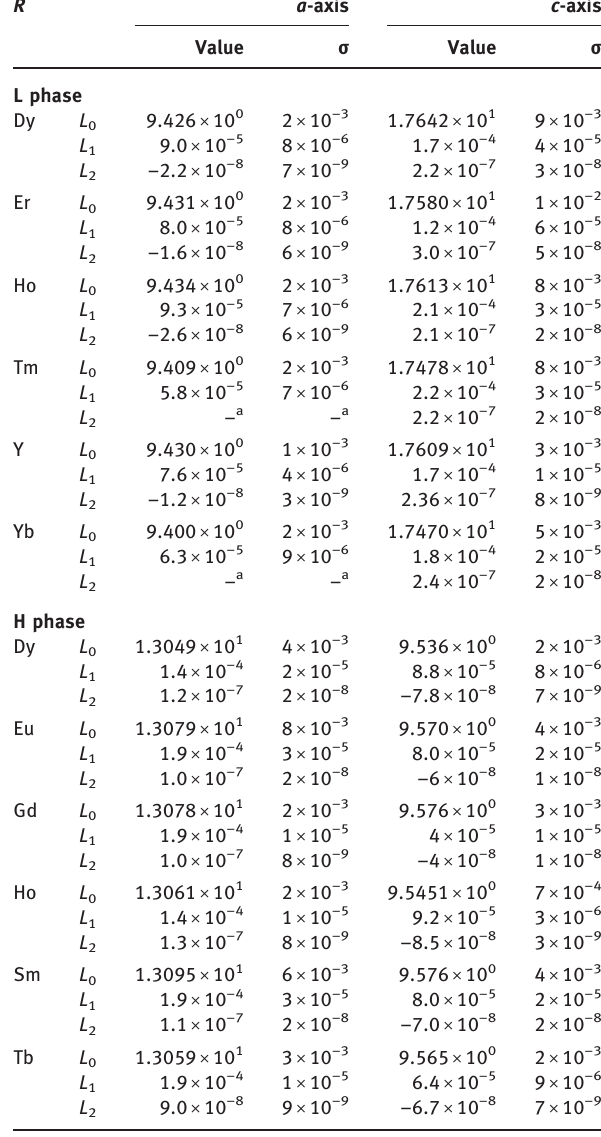
Table 1: The fitted coefficients for the quadratic curve shown in Figure 5 ( L = L 0 + L 1 T + L 2 T 2